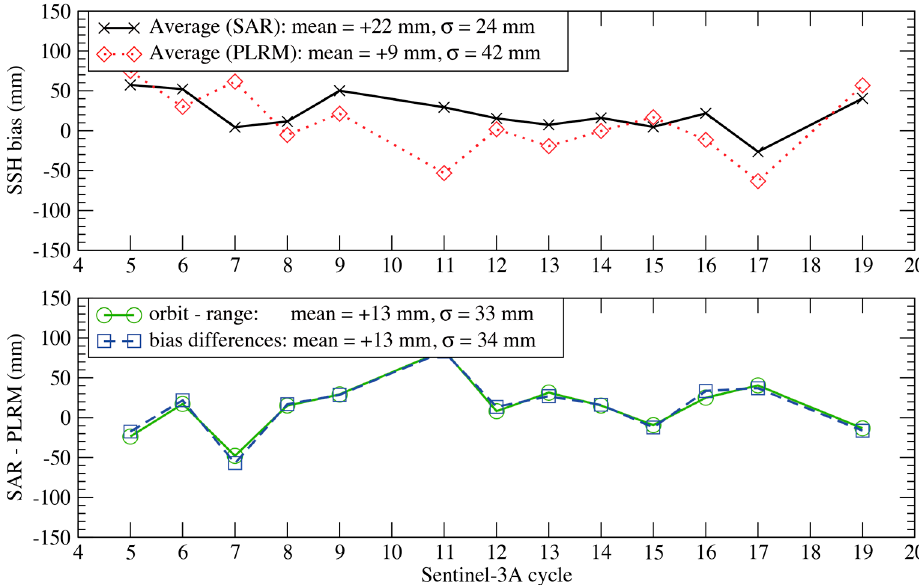
Figure 7. Average of Senetosa and Ajaccio Sentinel-3A SSH biases for both SAR and PLRM (upper panel). The lower panel shows the differences between SAR and PLRM for the “orbit-range” (green circles) and the total SSH bias (blue squares).